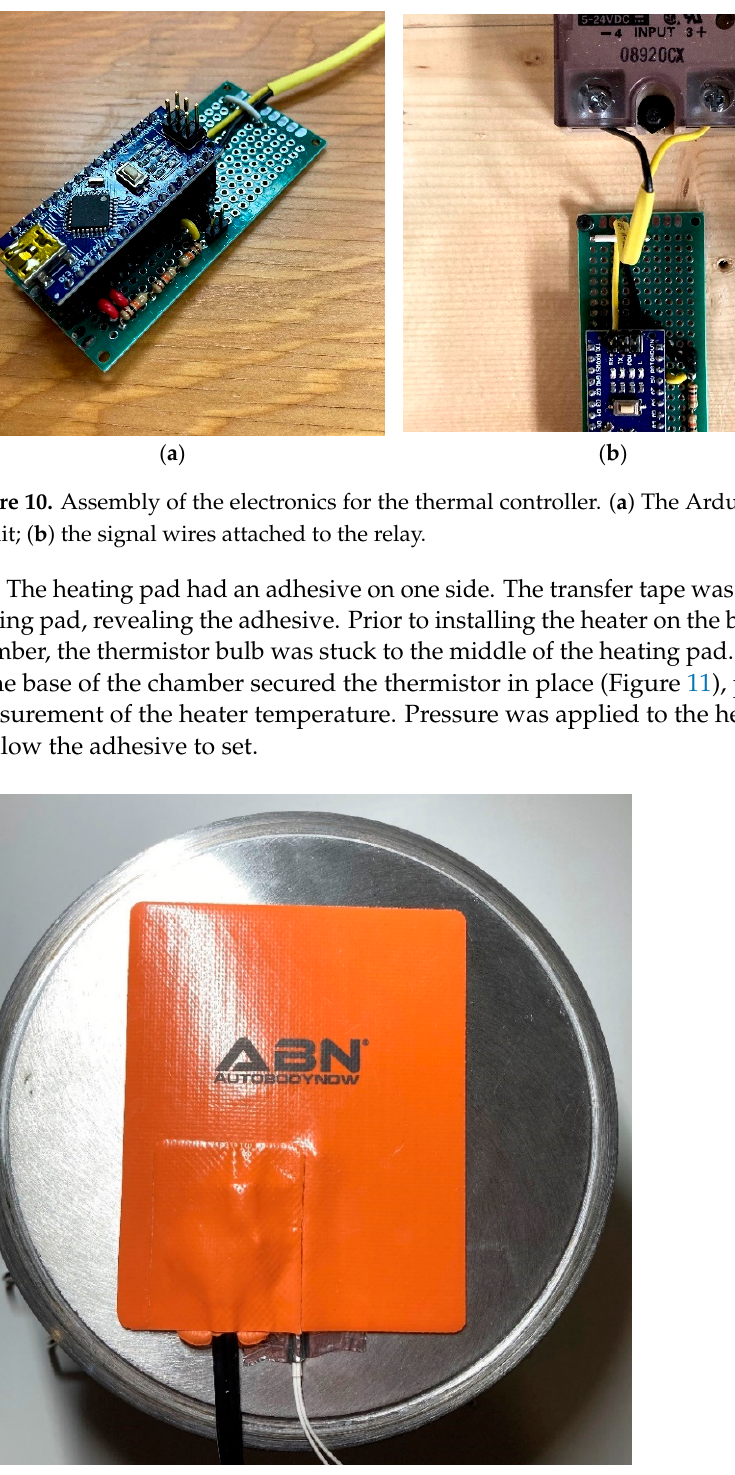
Figure 11. The heating element was adhered to the base of the chamber, with the thermistor secured on the interface.